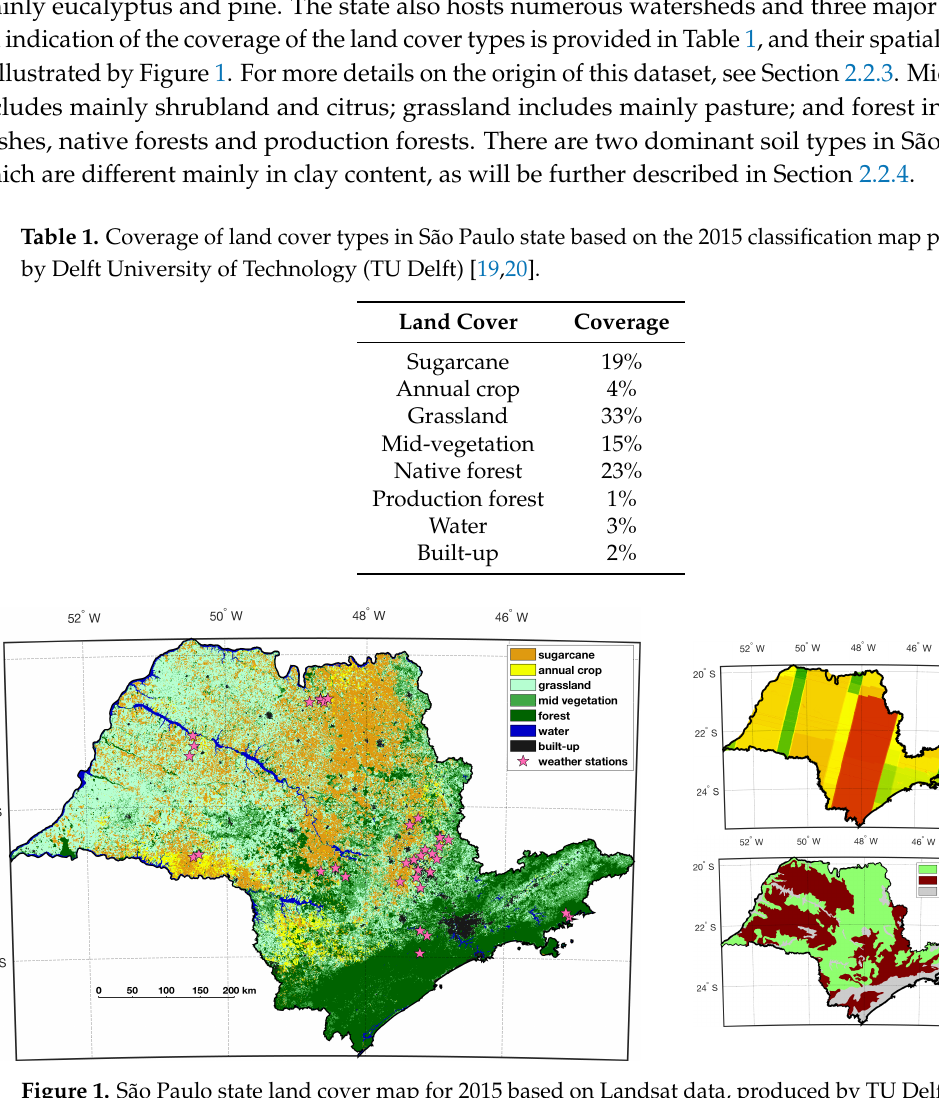
Figure 1. São Paulo state land cover map for 2015 based on Landsat data, produced by TU Delft [19,20] (left), the number of Sentinel-1 Interferometric-Wide acquisitions (top right) and the location of the two soil types (bottom